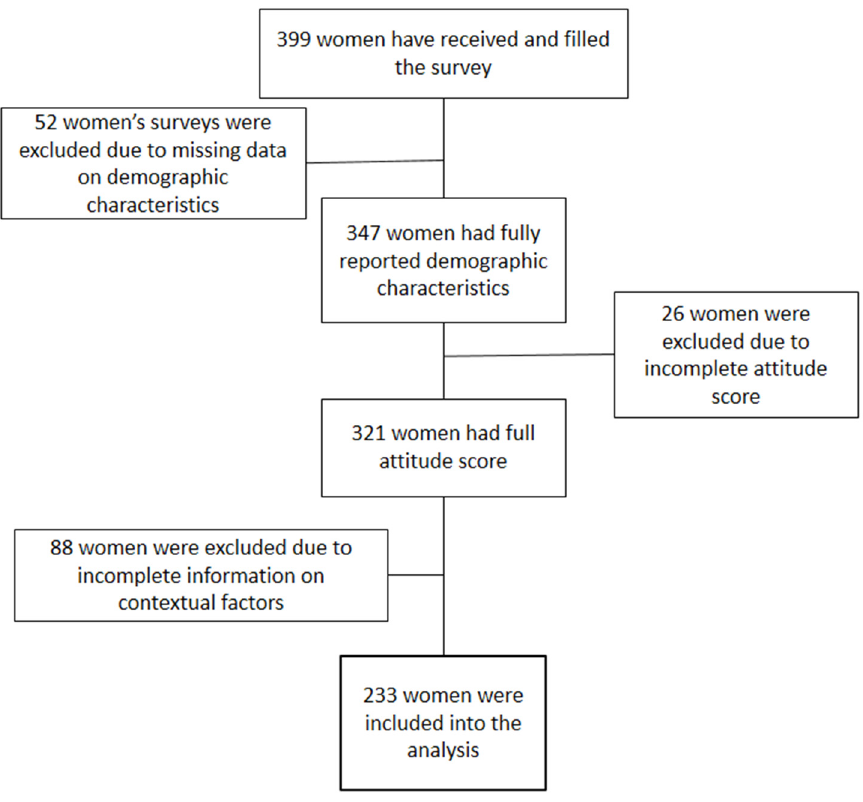
Figure 1. Flow chart on participants’ inclusion.